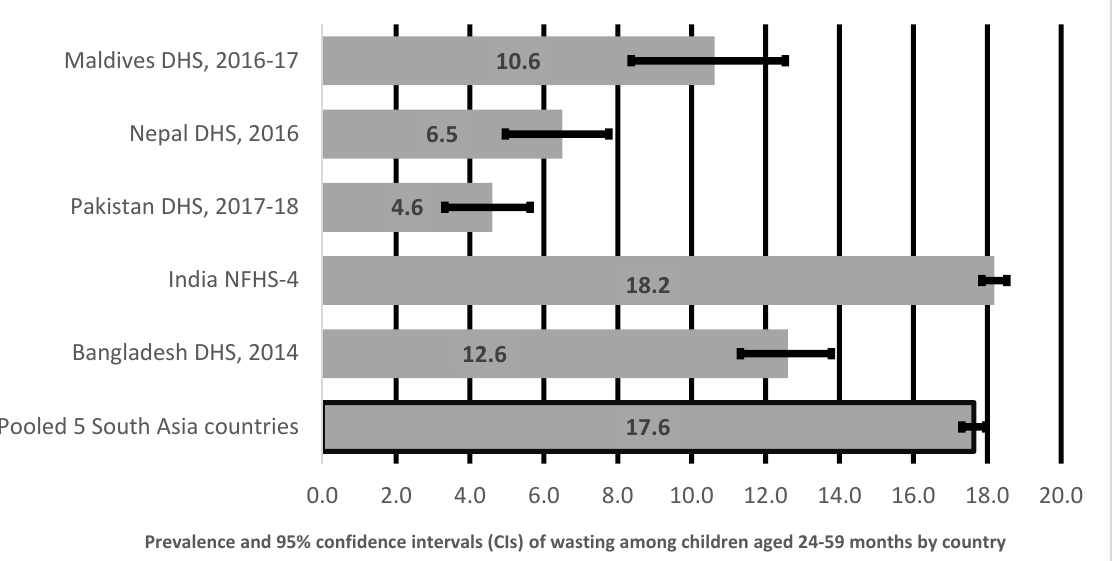
Figure 3. Prevalence and 95% confidence intervals of wasting in children aged 0–59 months in South Asia.